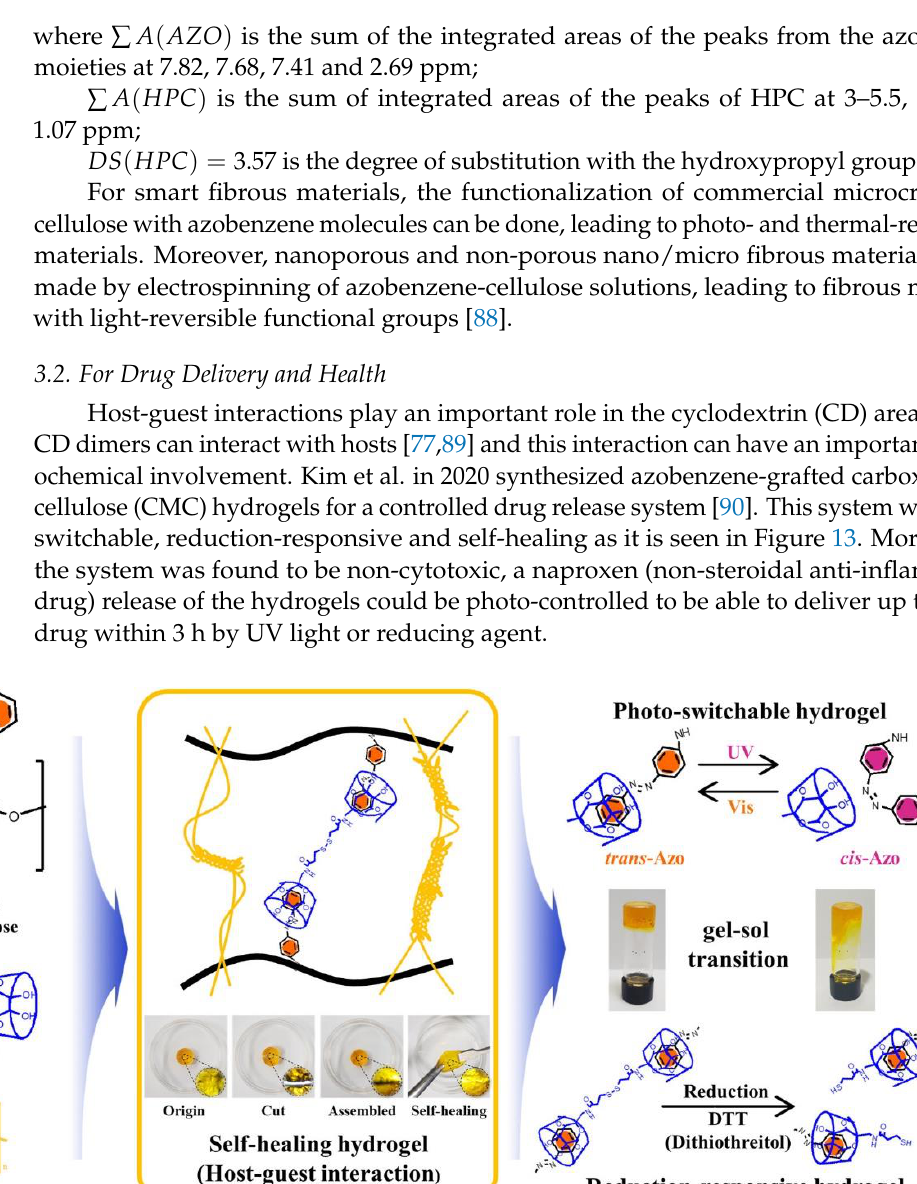
Figure 14. AZO-EHPC or AZO-HPHPC formula. Smart responsive nanomaterials have received much attention over the last decade for their functional properties in response to environmental variables and especially light [93,94]. In this context, exploring photochromic cellulose nanocrystals (CNCs) functional- ized